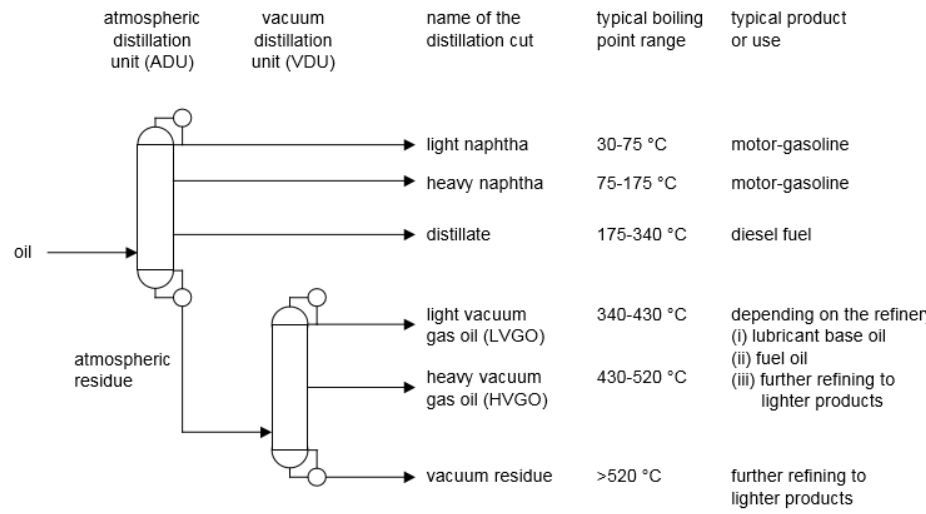
Figure 1. Straight run distillation cuts that are typically produced in an oil refinery.